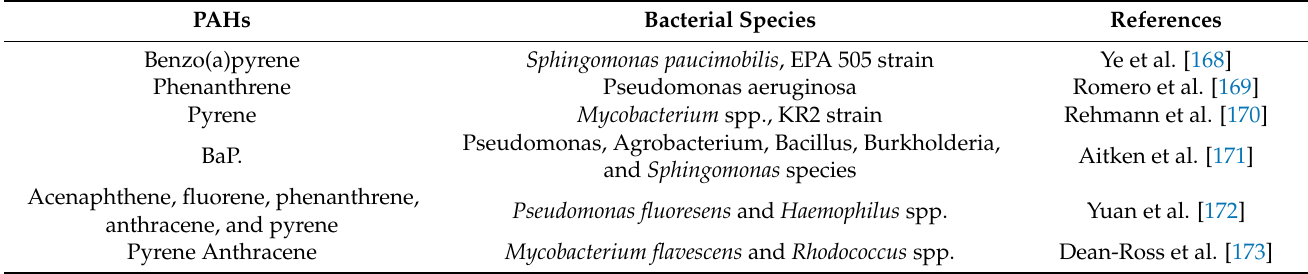
Table 2. Bacteria used for the biodegradation of